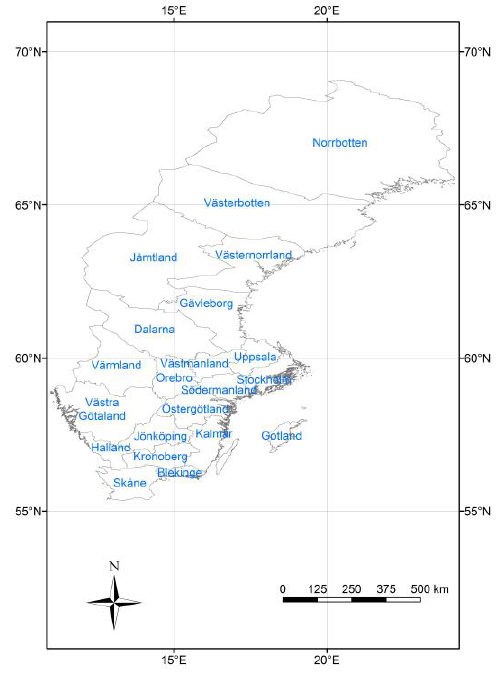
Figure 2. Map of Sweden with names and borders of 21